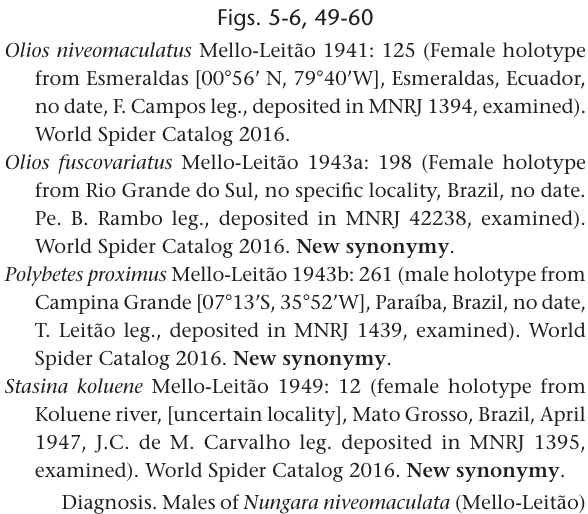
Olios niveomaculatus Mello-Leitão 1941: 125 (Female holotype from Esmeraldas [00°56’ N, 79°40’W], Esmeraldas, Ecuador, no date, F. Campos leg., deposited in MNRJ 1394, examined).